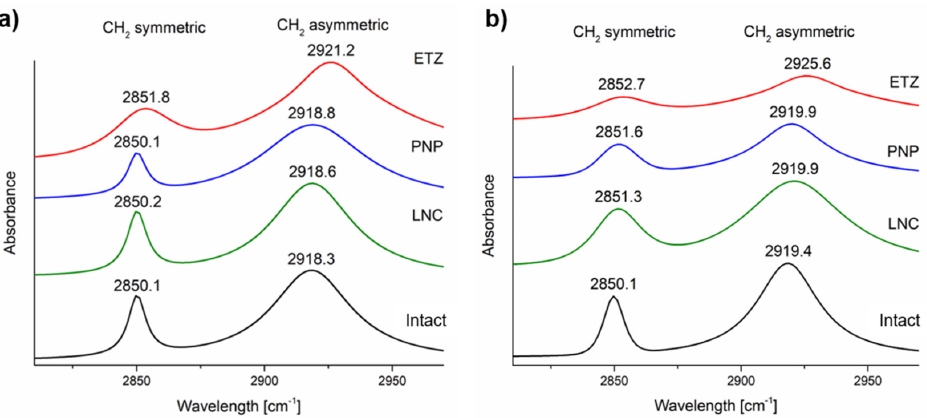
Figure 7. Fitted significant peaks of CH2 symmetric and asymmetric stretching from the ATR-FTIR spectra of ( a ) porcine, ( b ) human skin treated by lipid nanocapsules (LNC), polymeric nanoparticles (PNP), and ethosomes (ETZ).